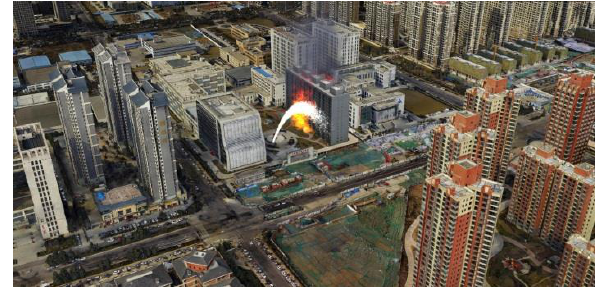
Figure 12. Snow scenario